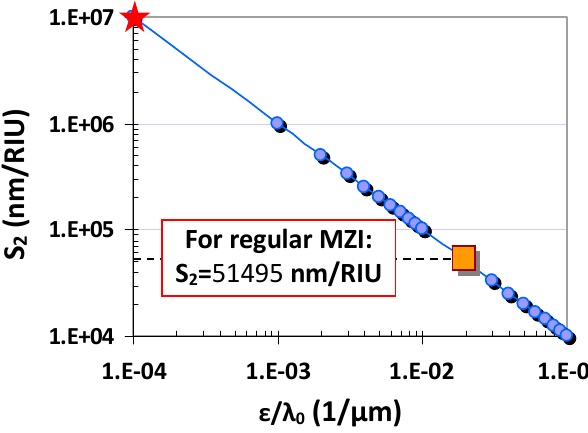
Figure 2. The device sensitivity S 2 as the value ε / λ 0 varies.